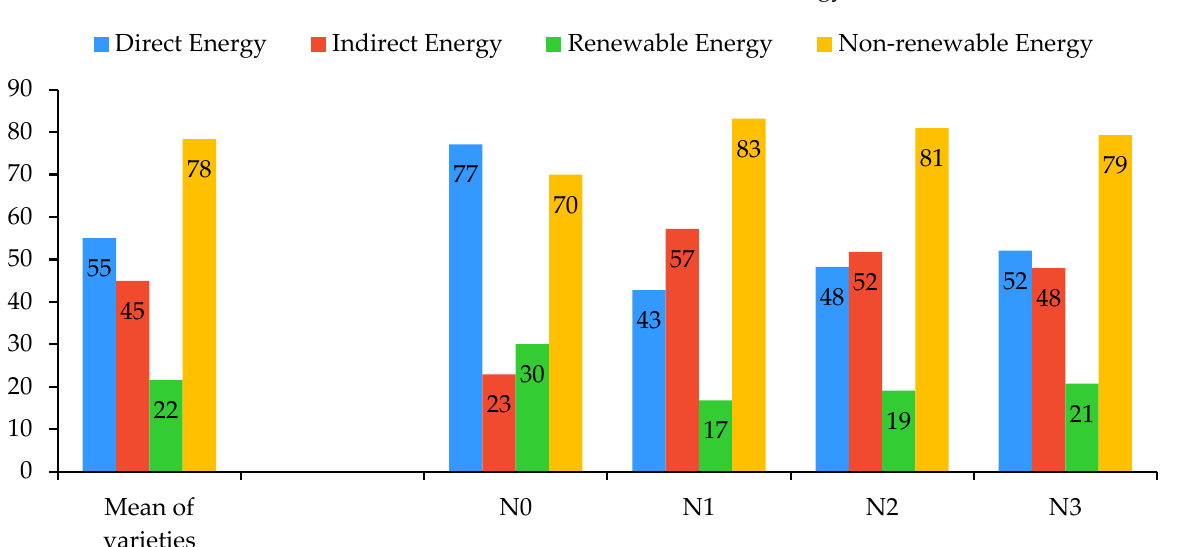
Figure 6. Percentage share of direct, indirect, renewable, and non-renewable energy sources to different nutrient management treatments and mean of varieties (mean of two years).